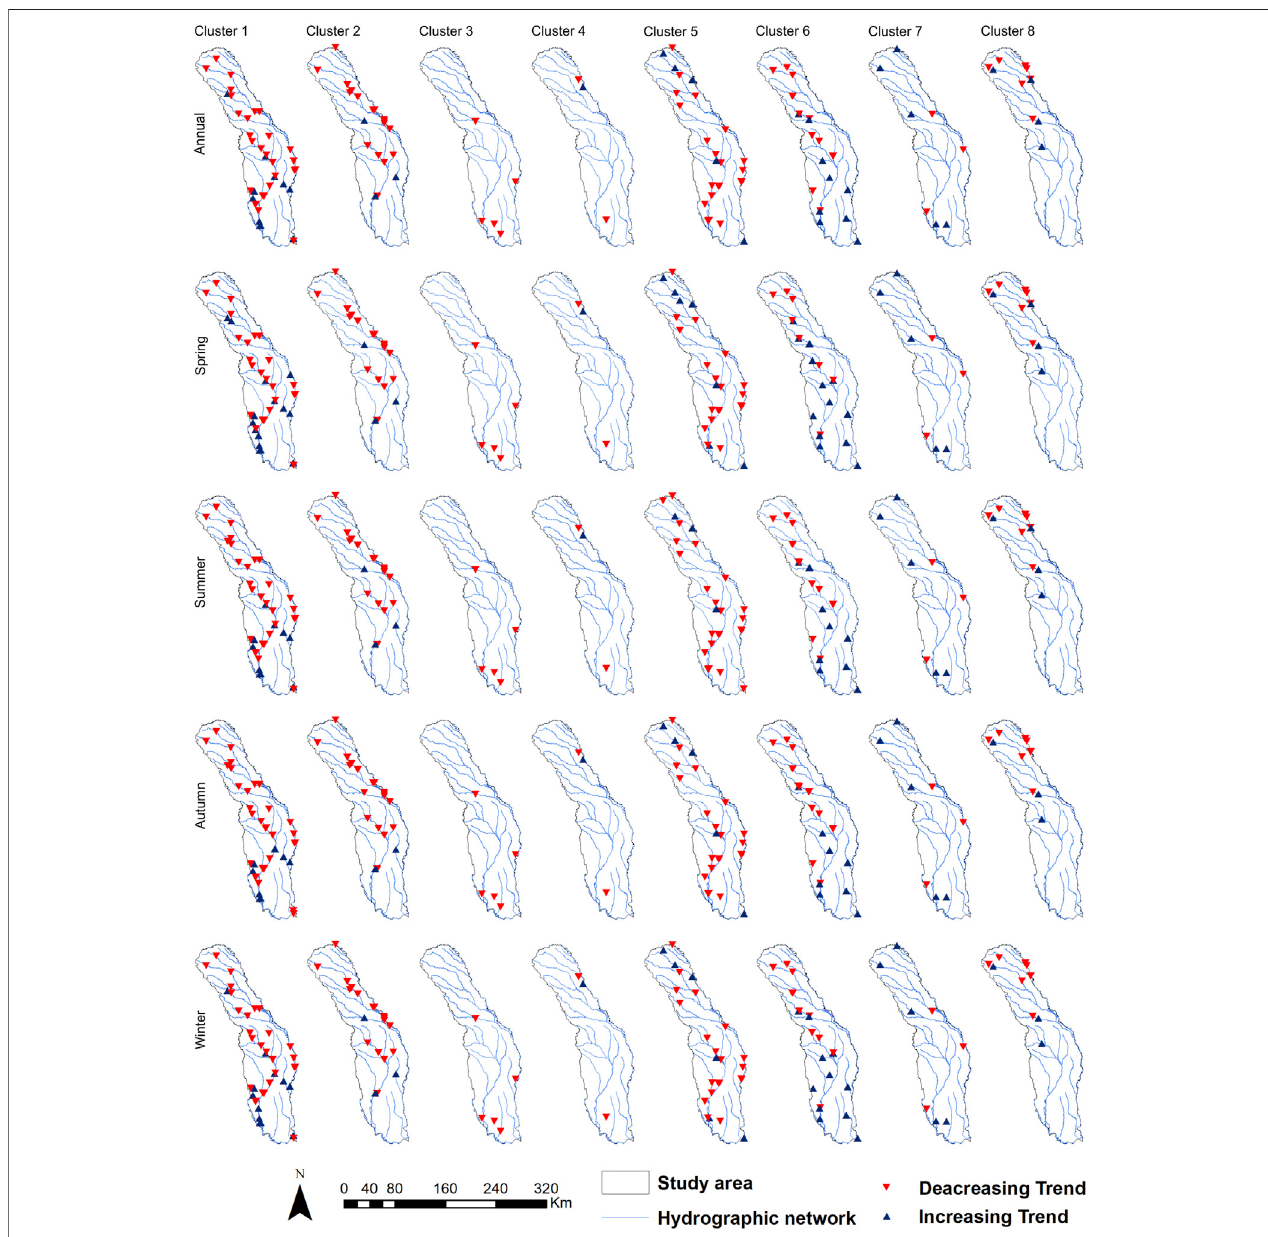
FIGURE 8 | Spatial distributions of the seasonal and annual trends at the cluster level using SR